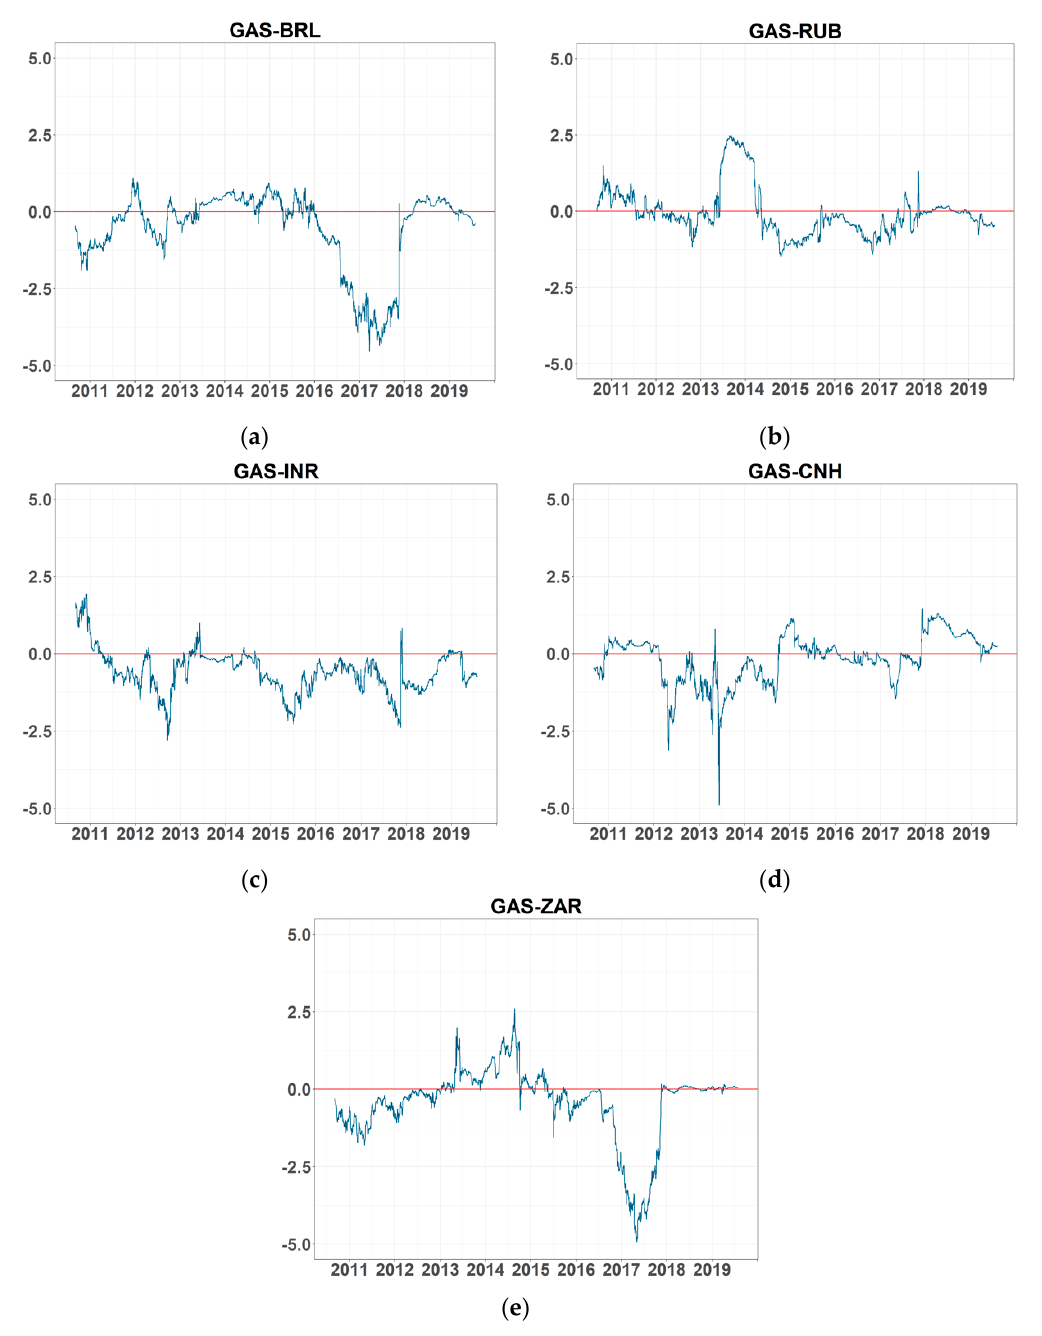
Figure A4. Net pairwise connectedness of return series: ( a – e ) refer to the net pairwise connectedness between GASS and BRL, RUB, INR, CNH, and ZAR return series, respectively. Note: BRL, RUB, INR, CNH, and ZAR are Brazilian Real, Russian Ruble, Indian Rupee, offshore Chinese Yuan, and South African Rand, respectively. GASF is the Henry Hub natural gas futures price.